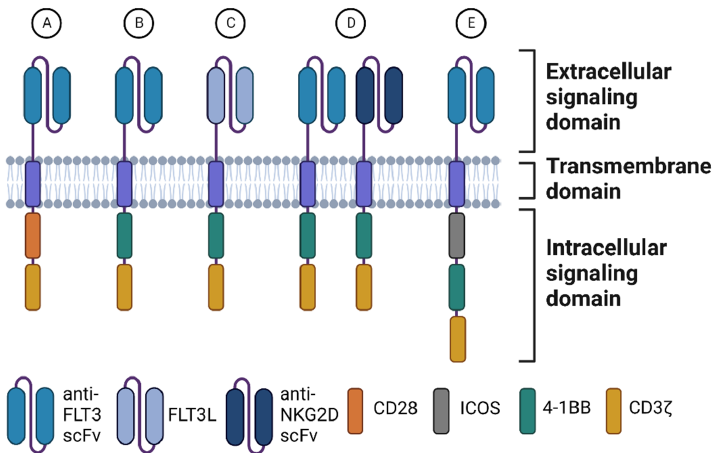
Figure 1. An overview of different anti-FLT3 CAR T-cells developed to date. ( A ) A second-generation CAR with CD28 as co-stimulatory domain [30–32]. ( B ) A second-generation CAR with 4-1BB as co-stimulatory domain [30,33]. ( C ) A second-generation CAR with 4-1BB as co-stimulatory domain and the FLT3 ligand (FLT3L) instead of an anti-FLT3 scFv [34]. ( D ) Two CARs with scFvs targeting FLT3 and NKG2DS, respectively. The CARs were encoded on a bicistronic lentiviral vector using the same promoter and separated by a self-cleaving 2A peptide to ensure equal expression on the cell surface [35]. ( E ) A third generation anti-FLT3 CAR with two co-stimulatory domains, 4-1BB and inducible T-cell co-stimulator (ICOS) [36].